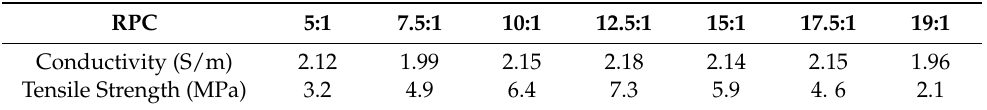
Table 1. Electrical and mechanical properties of fabricated nanocomposites under variable